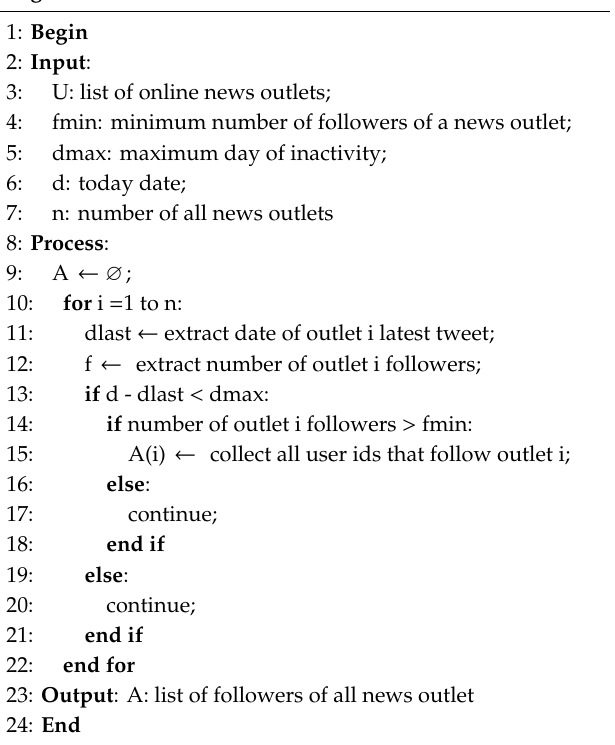
Algorithm 1 follower